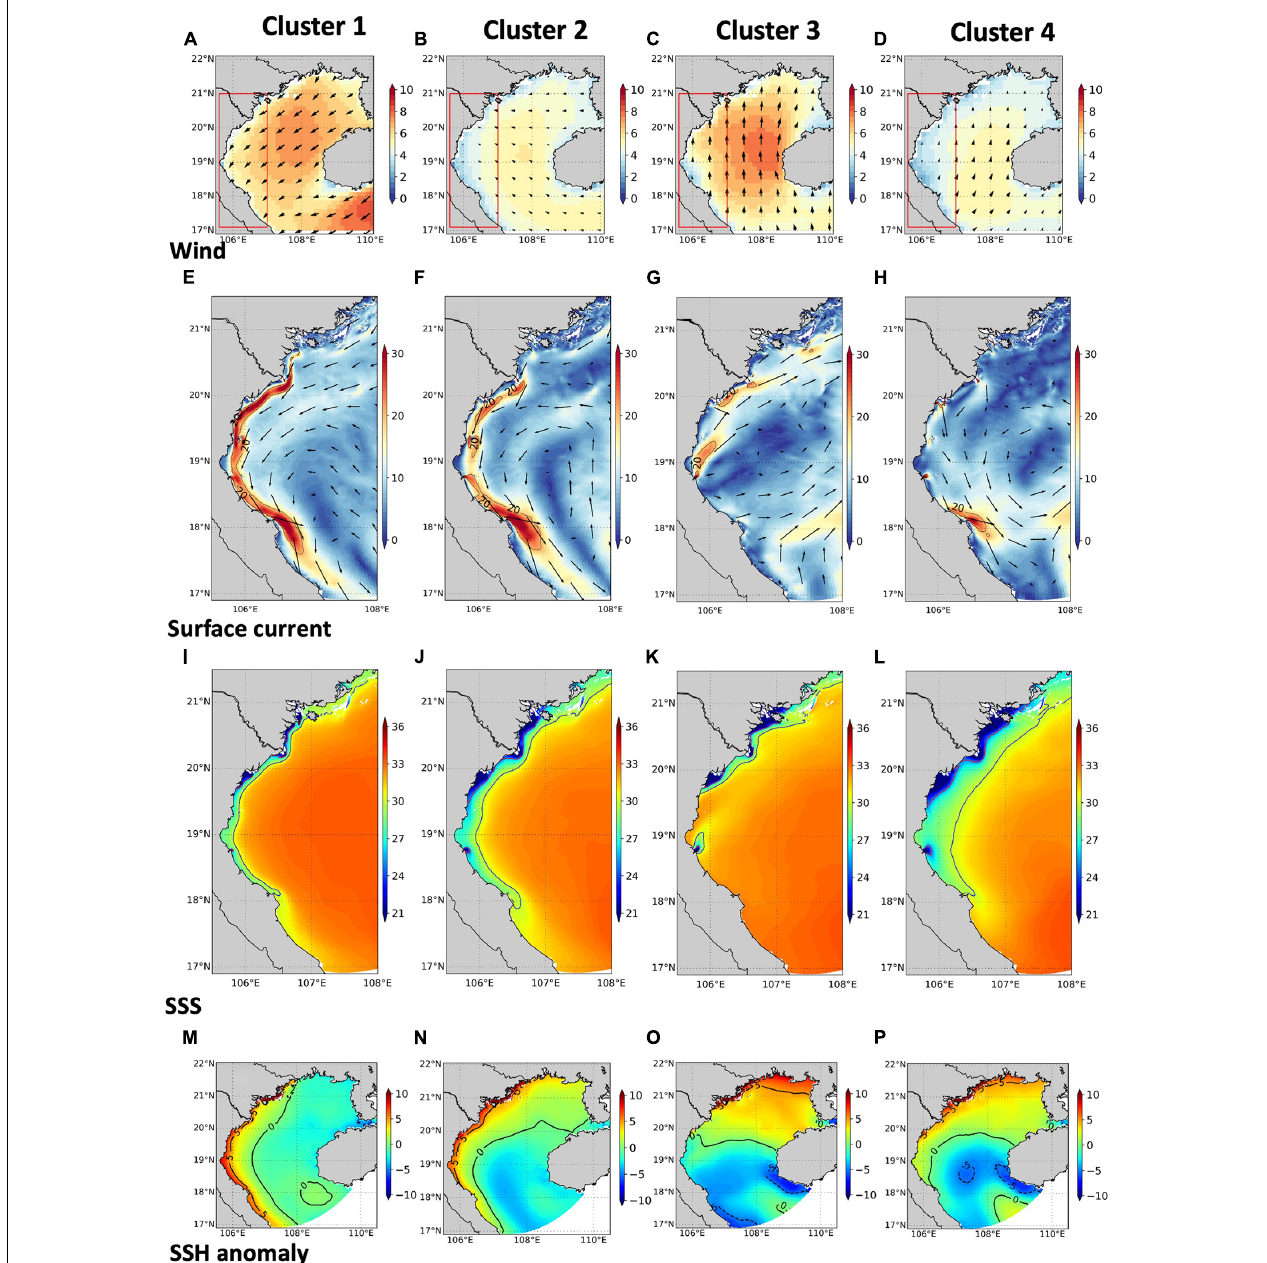
FIGURE 10 | (A–D) Wind conditions (m/s) corresponding to the 4 clusters. (E–H) and (I–L) Same as (A–D) but for surface current (cm/s) and SSS. (M–P) SSH anomaly with respect to the mean over the basin for each cluster (cm).